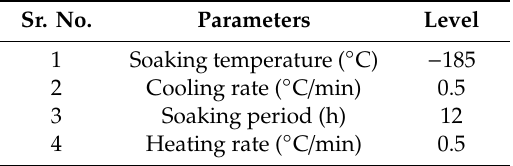
Table 3. Description of deep cryogenic treatment (DCT) process parameters.